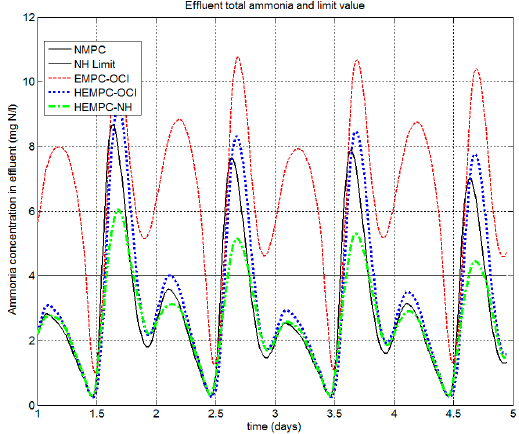
Figure 9. Ammonium concentration in the effluent for selected controller designs.